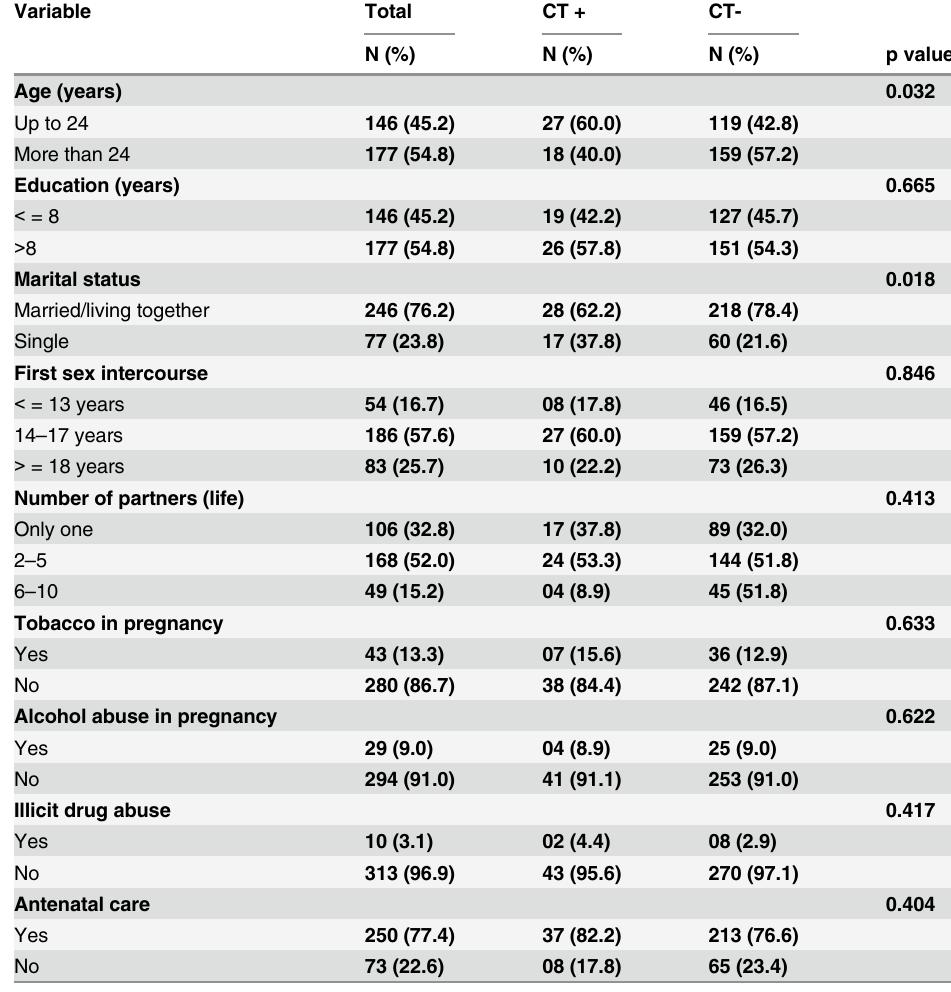
Table 1. Demographic and behavior characteristics reported by parturient women delivering preterm babies in Vitoria, 2013 by Chlamydia trachomatis (n = 323).